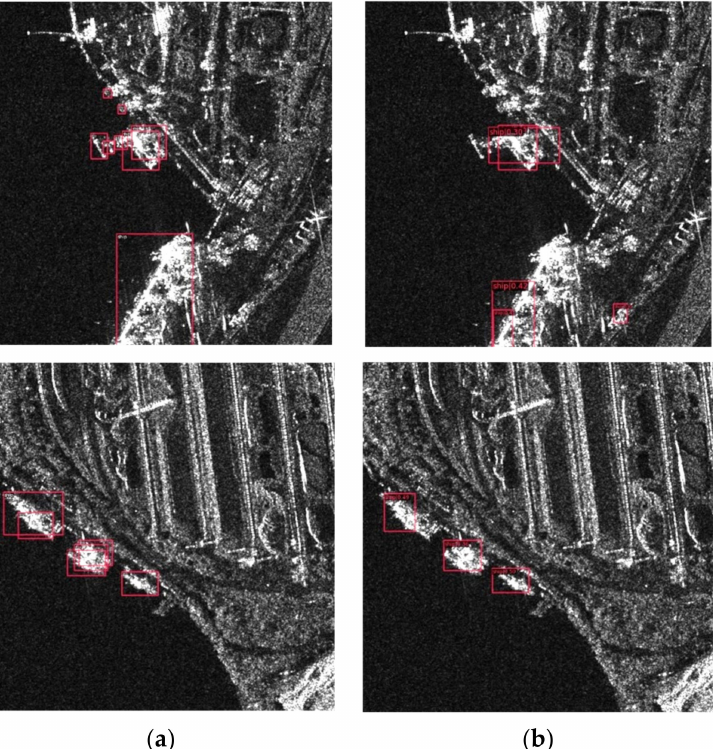
Figure 13. Images with unsatisfactory detection results: ( a ) ground truth; ( b ) detection results of the proposed